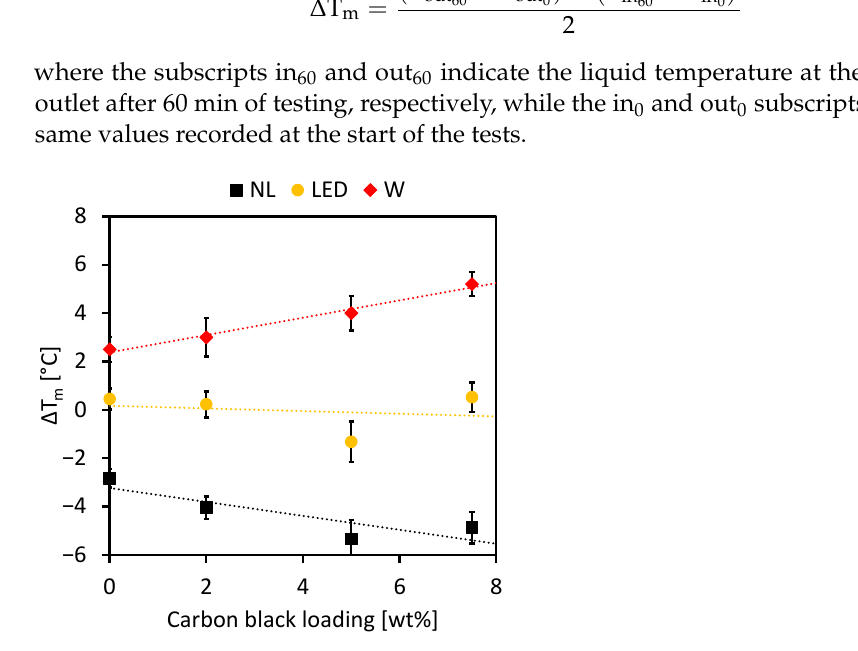
Figure 8. Mean feed temperature difference between MD test end and start with no light (NL, black), LED lamp (yellow) and incandescent light bulb (W, red).